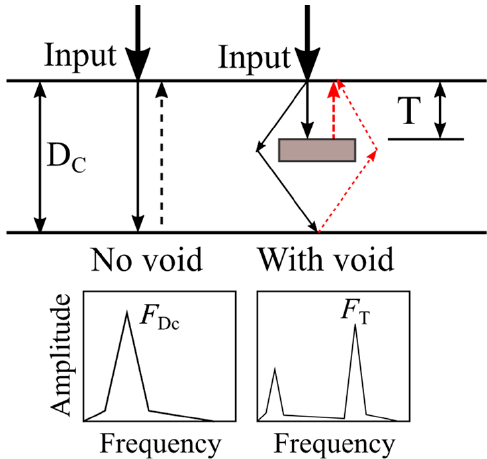
Figure 4. Schematic of the propagation path and frequency of elastic waves in the internal void.